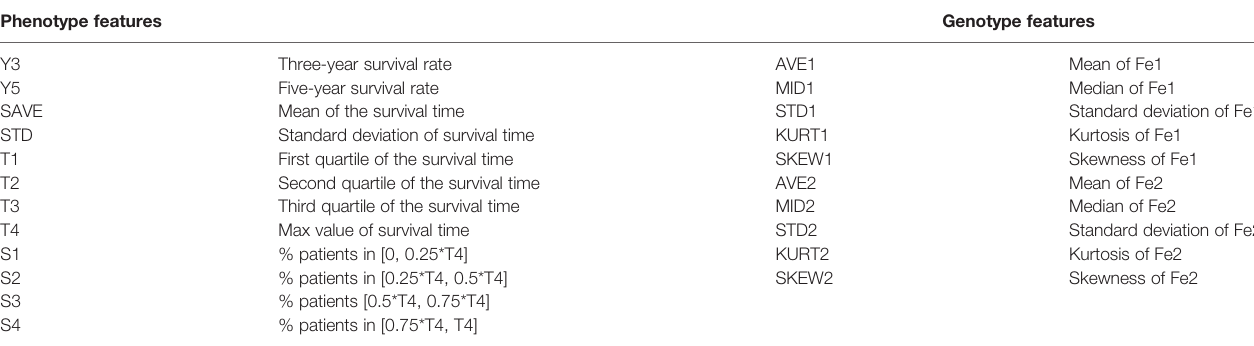
TABLE 1 | The features used for describing the survival situations of cancer